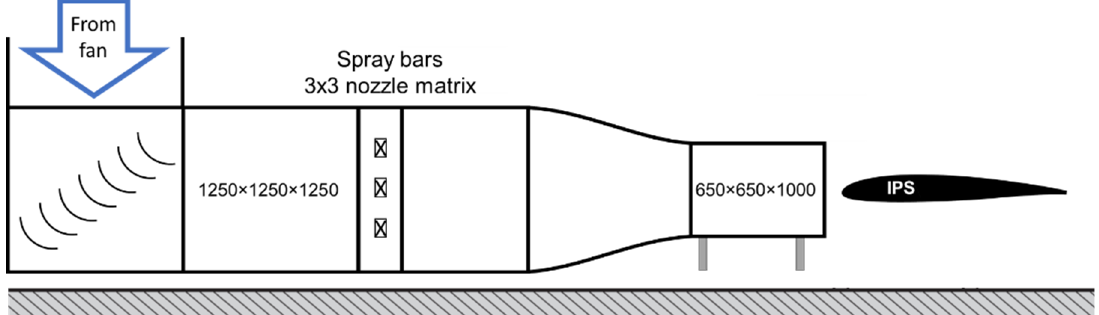
Figure 4. Schematics of the icing wind tunnel facility with the ice protection system.